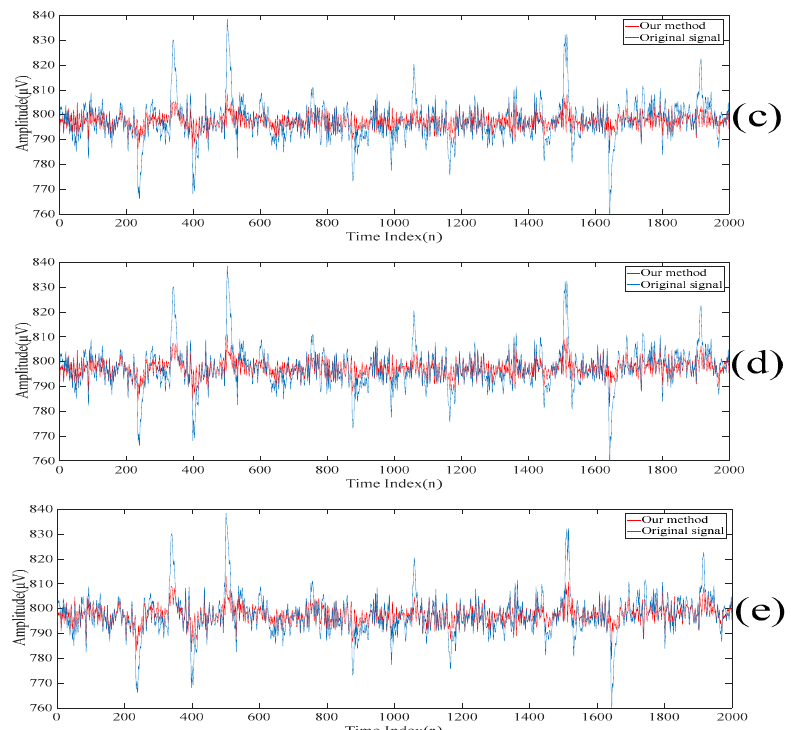
Figure 10. ( a ) The second scale of the electroencephalogram in the time domain. ( b ) The fourth scale of the electroencephalogram in the time domain. ( c ) The sixth scale of the electroencephalogram in the time domain. ( d ) The eighth scale of the electroencephalogram in the time domain. ( e ) The tenth scale of the electroencephalogram in the time domain.